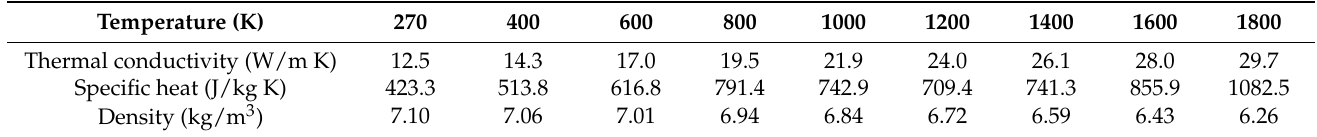
Table 2. Thermal physical of FeCrAl.